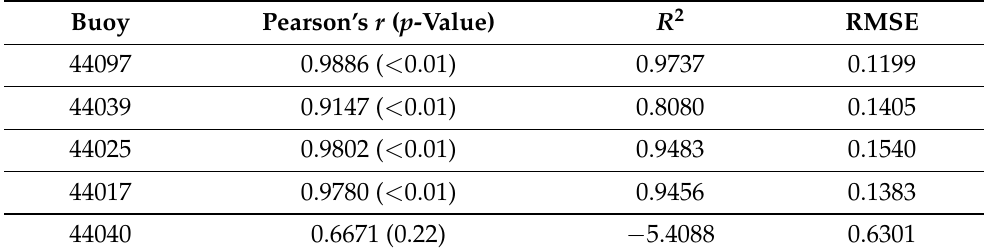
Table 3. Correlation, coefficient of determination R 2 and Root Mean Square Errors (RMSE) between in situ and SARAL/AltiKa H s measurements for the matched